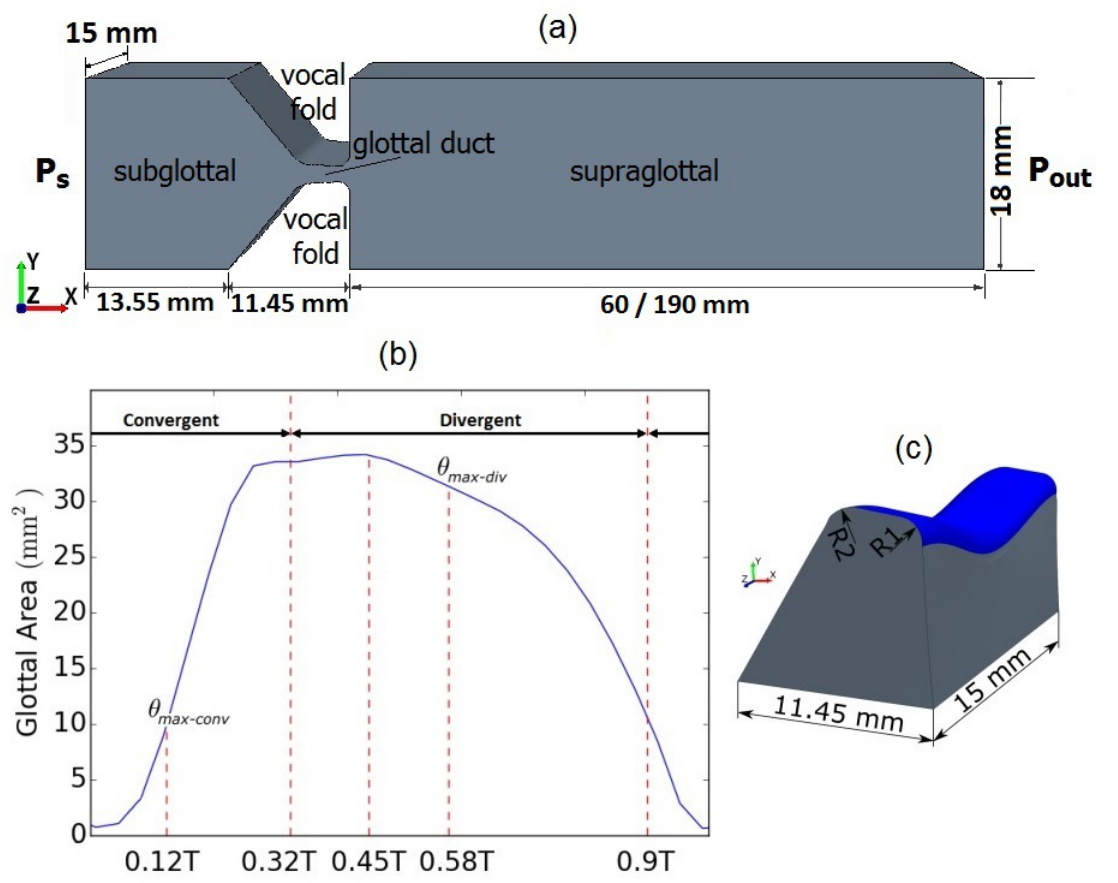
Figure 2. ( a ) Schematic of the numerical larynx model. ( b ) Glottal area waveform based on the experimental model flow-induced motion of vocal folds. ( c ) Geometry of the vocal fold at the middle of the cycle. The medial surface is defined with blue. R1 = 1 mm and R2 = 2 mm.